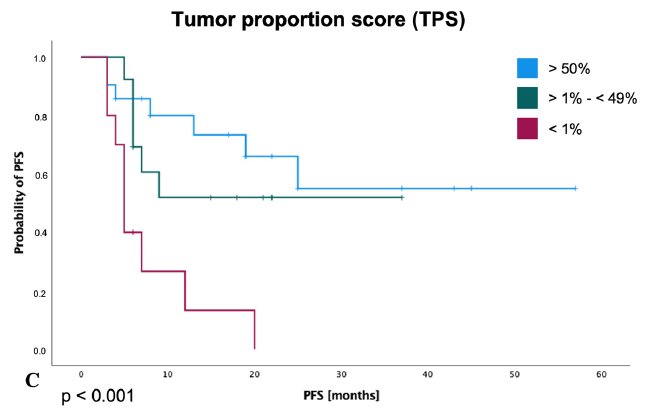
Figure 4. Progression-free survival for selected radiomic features and TPS score. Patients with a lower value of PET-Skewness with threshold (T): 0.2014 ( A ) and a higher value of PET-Median with threshold (T): 0.5233 ( B ) had a statistically significantly longer PFS. A higher TPS score ( C ) was also associated with a significantly longer PFS.